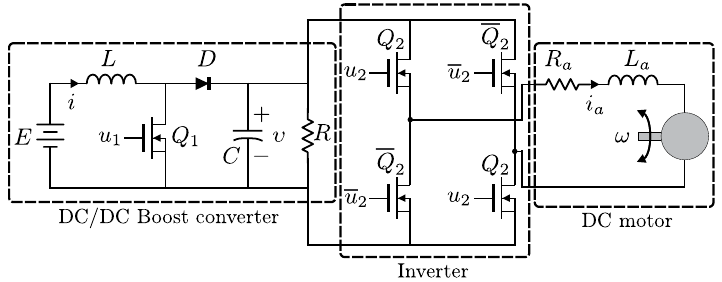
Figure 1. DC/DC boost converter–inverter–DC motor